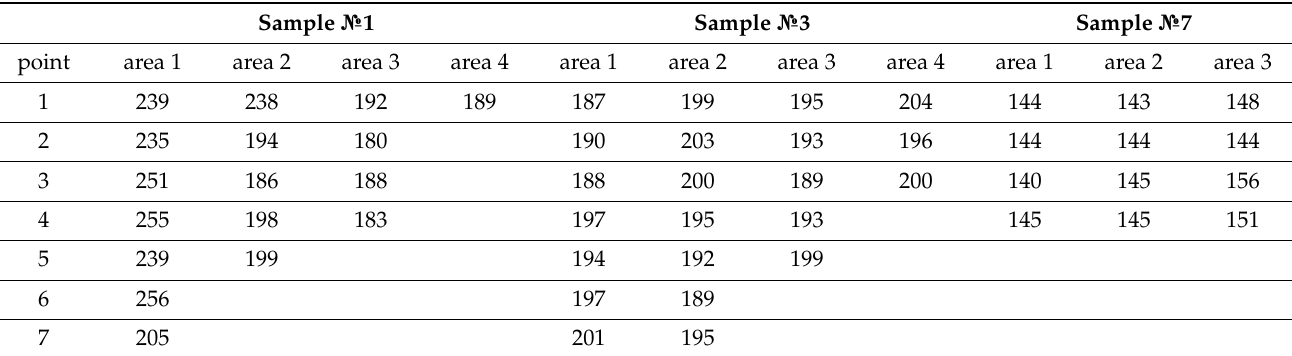
Table 3. Stress intensity values (MPa) of cast iron in the studied flange